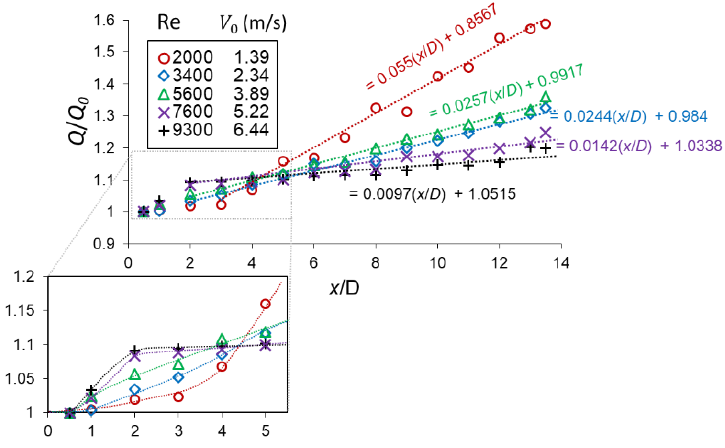
Figure 8. Centerline characteristics of mean and turbulent flow field.